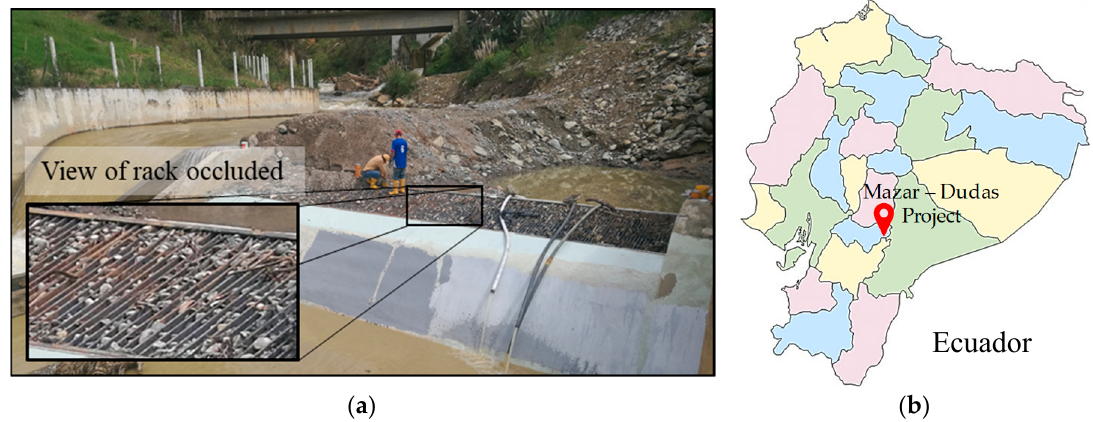
Figure 2. Mazar–Dudas Hydroelectric Project: ( a ) San Antonio bottom rack intake embedded in a weir—cleaning tasks and repairing process after a flood in the Mazar River, Ecuador (Image courtesy of Corporación Hidroeléctrica del Ecuador-CELEC EP Hidroazogues) [3]; ( b ) project location in Ecuador (without scale).